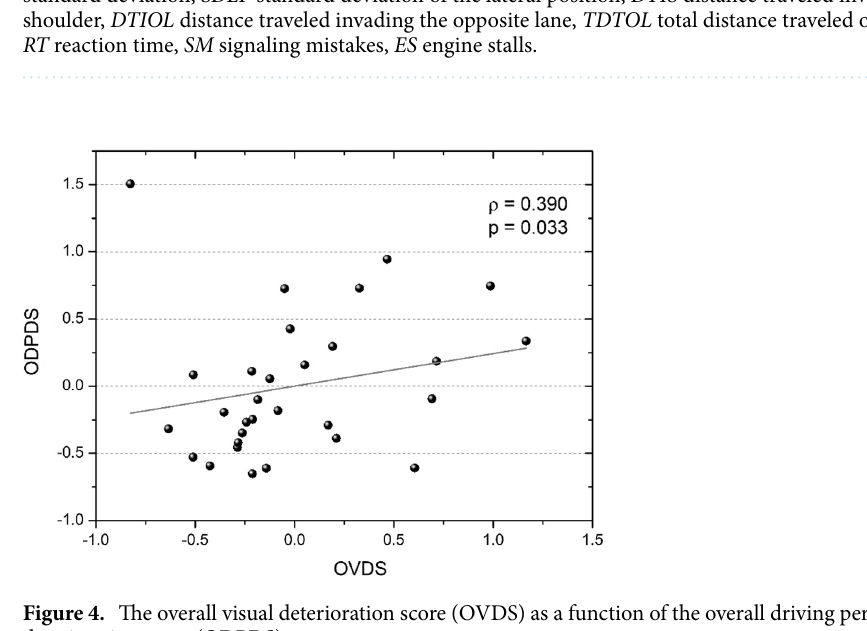
Figure 4. The overall visual deterioration score (OVDS) as a function of the overall driving performance deterioration score